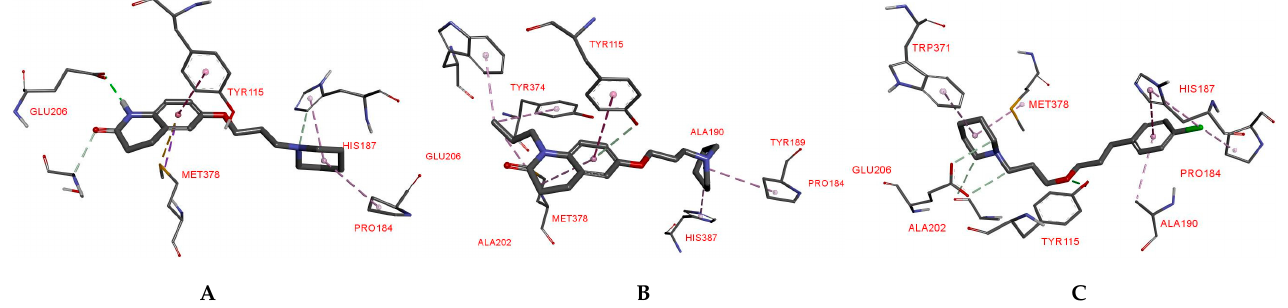
Figure 6. The predicted binding configurations when 2h ( A ), 4a ( B ), and PIT ( C ) dock with H 3 R.